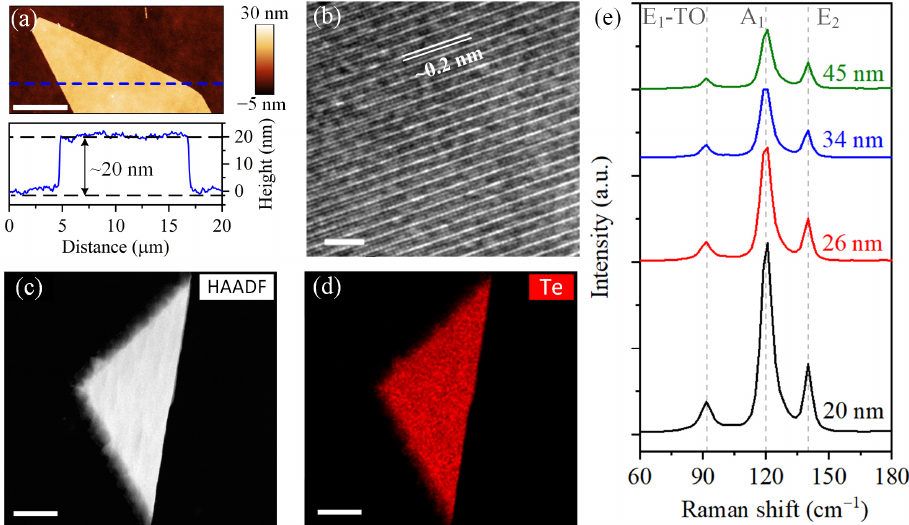
Figure 1. Synthesized Te flakes and material characterization. ( a ) AFM image (the top inset image) of a Te nano-flake with thickness of ~20 nm and the corresponding height profile (the bottom inset image, the position is shown by the blue dotted line in the top inset image), scale bar is 5 μ m; ( b ) HR-TEM image of atom strictures, scale bar is 4 nm; HAADF image ( c ) and EDS mapping image ( d ) of Te element; ( e ) Raman spectra of Te flakes with different thicknesses.